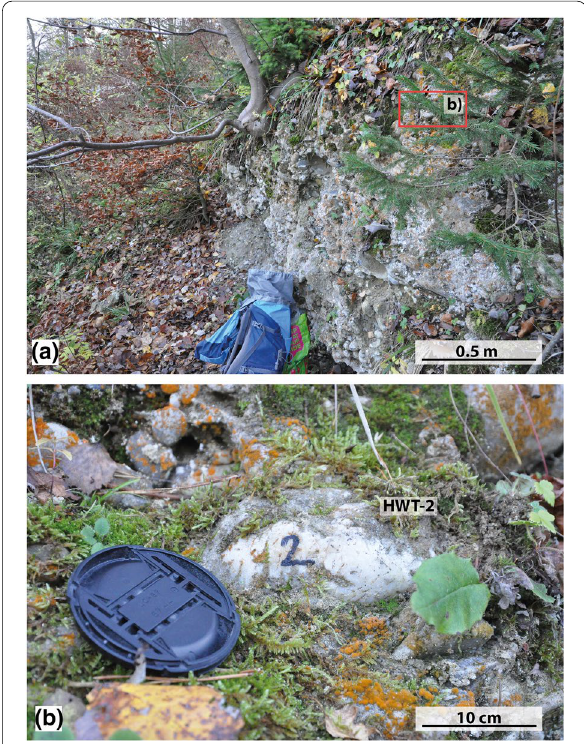
Fig. 5 Field photographs from the Hochwacht site. a Overview of the outcrop and the position of photograph b . b Photograph of the sample